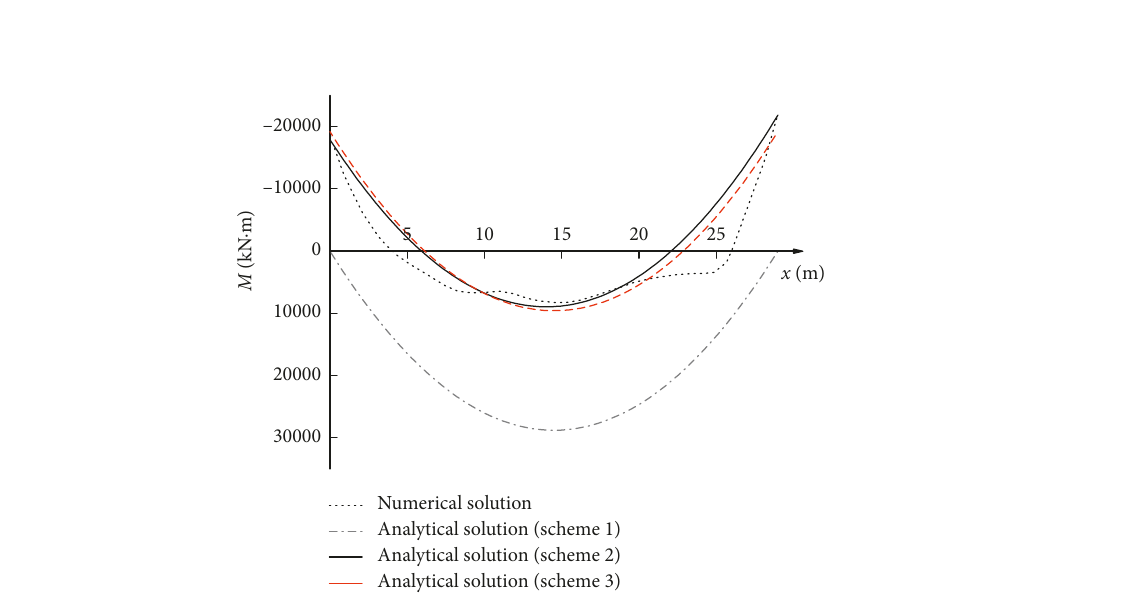
Figure 24: The bending moment of the cave roof. Table 5: Typical cases and the